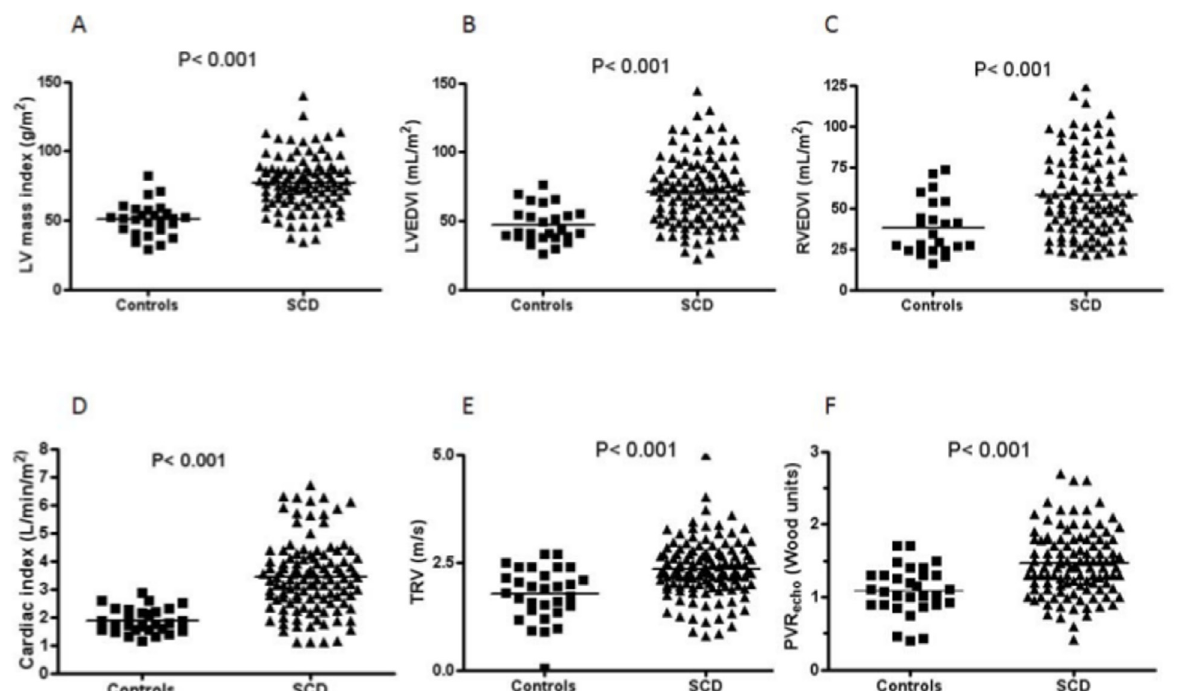
Fig 1. Scatter plots showing the distribution of values for echocardiographic parameters in SCD and control subjects. LVEDVI, LV end-diastolic volume index; RVEDVI, RV end-diastolic volume index.